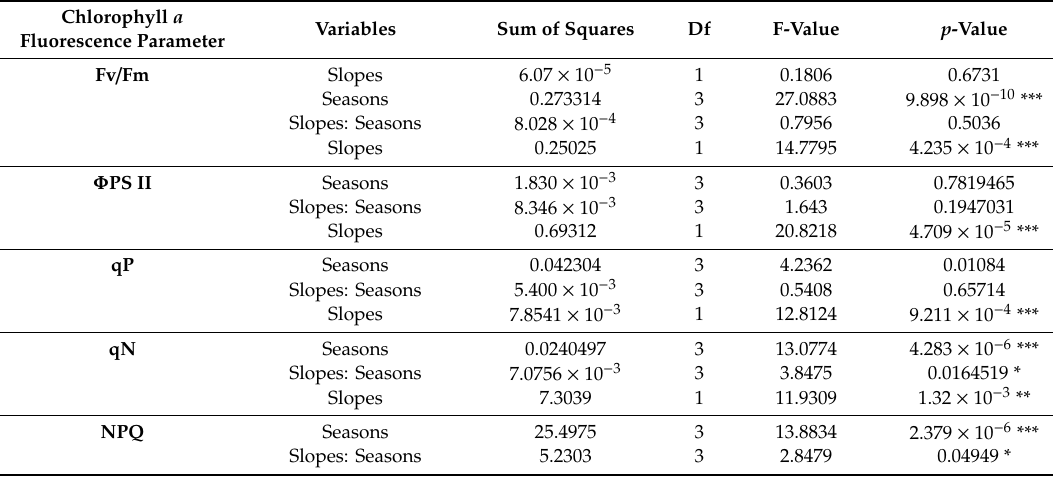
Table 3. Multivariate Analysis of Variance (MANOVA) results of chlorophyll a fluorescence parameter values (Fv / Fm, Φ PS II, qP, qN, NPQ) between slopes (NE and SW) with respect to di ff erent seasons (Spring, Summer, Autumn, Winter) in S. ruralis